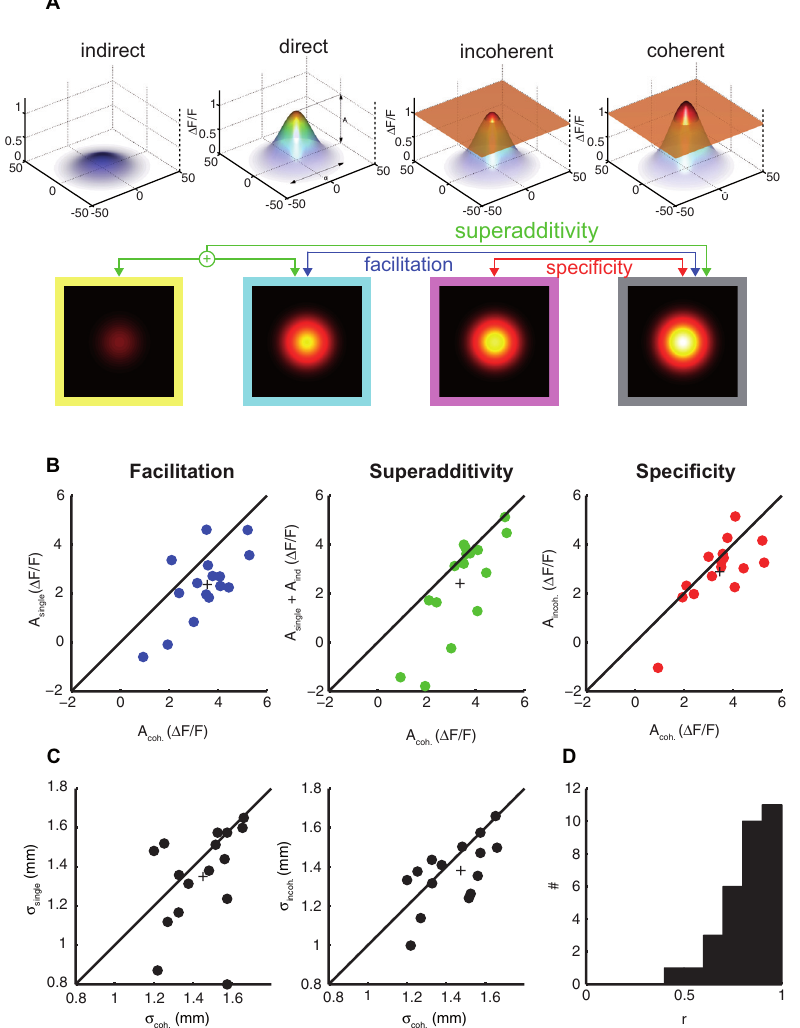
Figure 4. Distant natural stimulus exerts facilitatory effects on local activity levels. ( A ) Modeled activity profiles averaged across